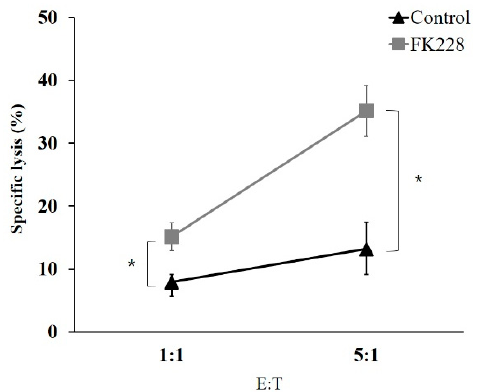
Figure 5. Selective cell death by NK cell cytotoxicity after treatment with FK228. NCI-H23 cells were treated with FK228 for 24 h at 100 nM and then stained with carboxyfluorescein succinimidyl ester (CFSE). The target cells were co-cultured with NK-92 cells for 4 h at effector-to-target ratios of 1:1 and 5:1. Flow cytometry was used to measure the proportion of PI-positive cells, which indicated NK cell-mediated lysis. * represents a statistically significant increase. p -values less than 0.05 is marked as * symbols.